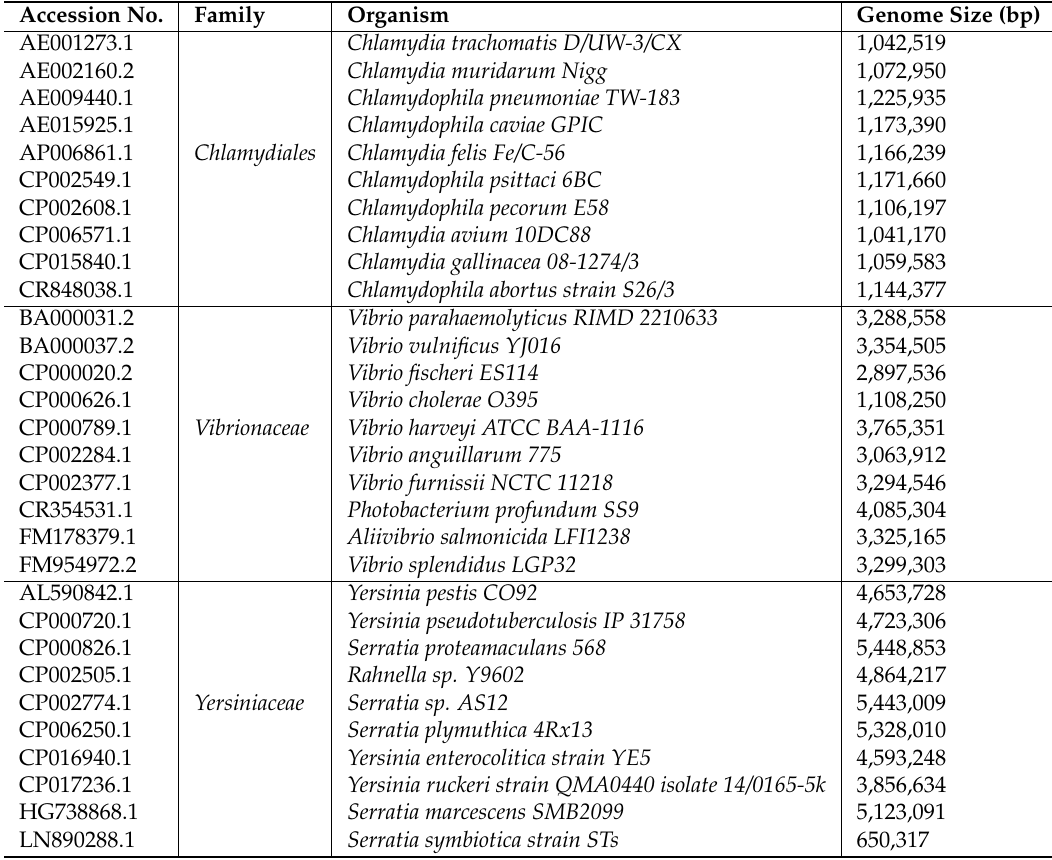
Table 1. Genomic information from bacteria selected for Whole-genome k -mer topic modeling